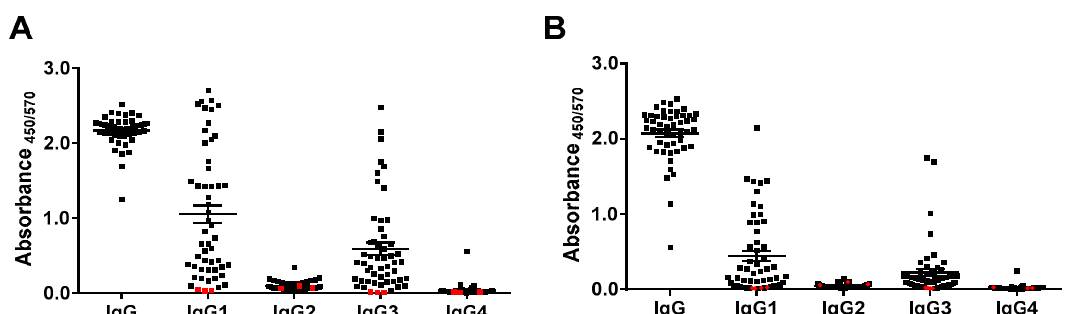
Figure 4. IgG isotyping using ( A ) S1- and ( B ) RBD-based tests. IgG: total IgG. Red squares represent negative controls. All serum samples were assayed at a 1:100 dilution.